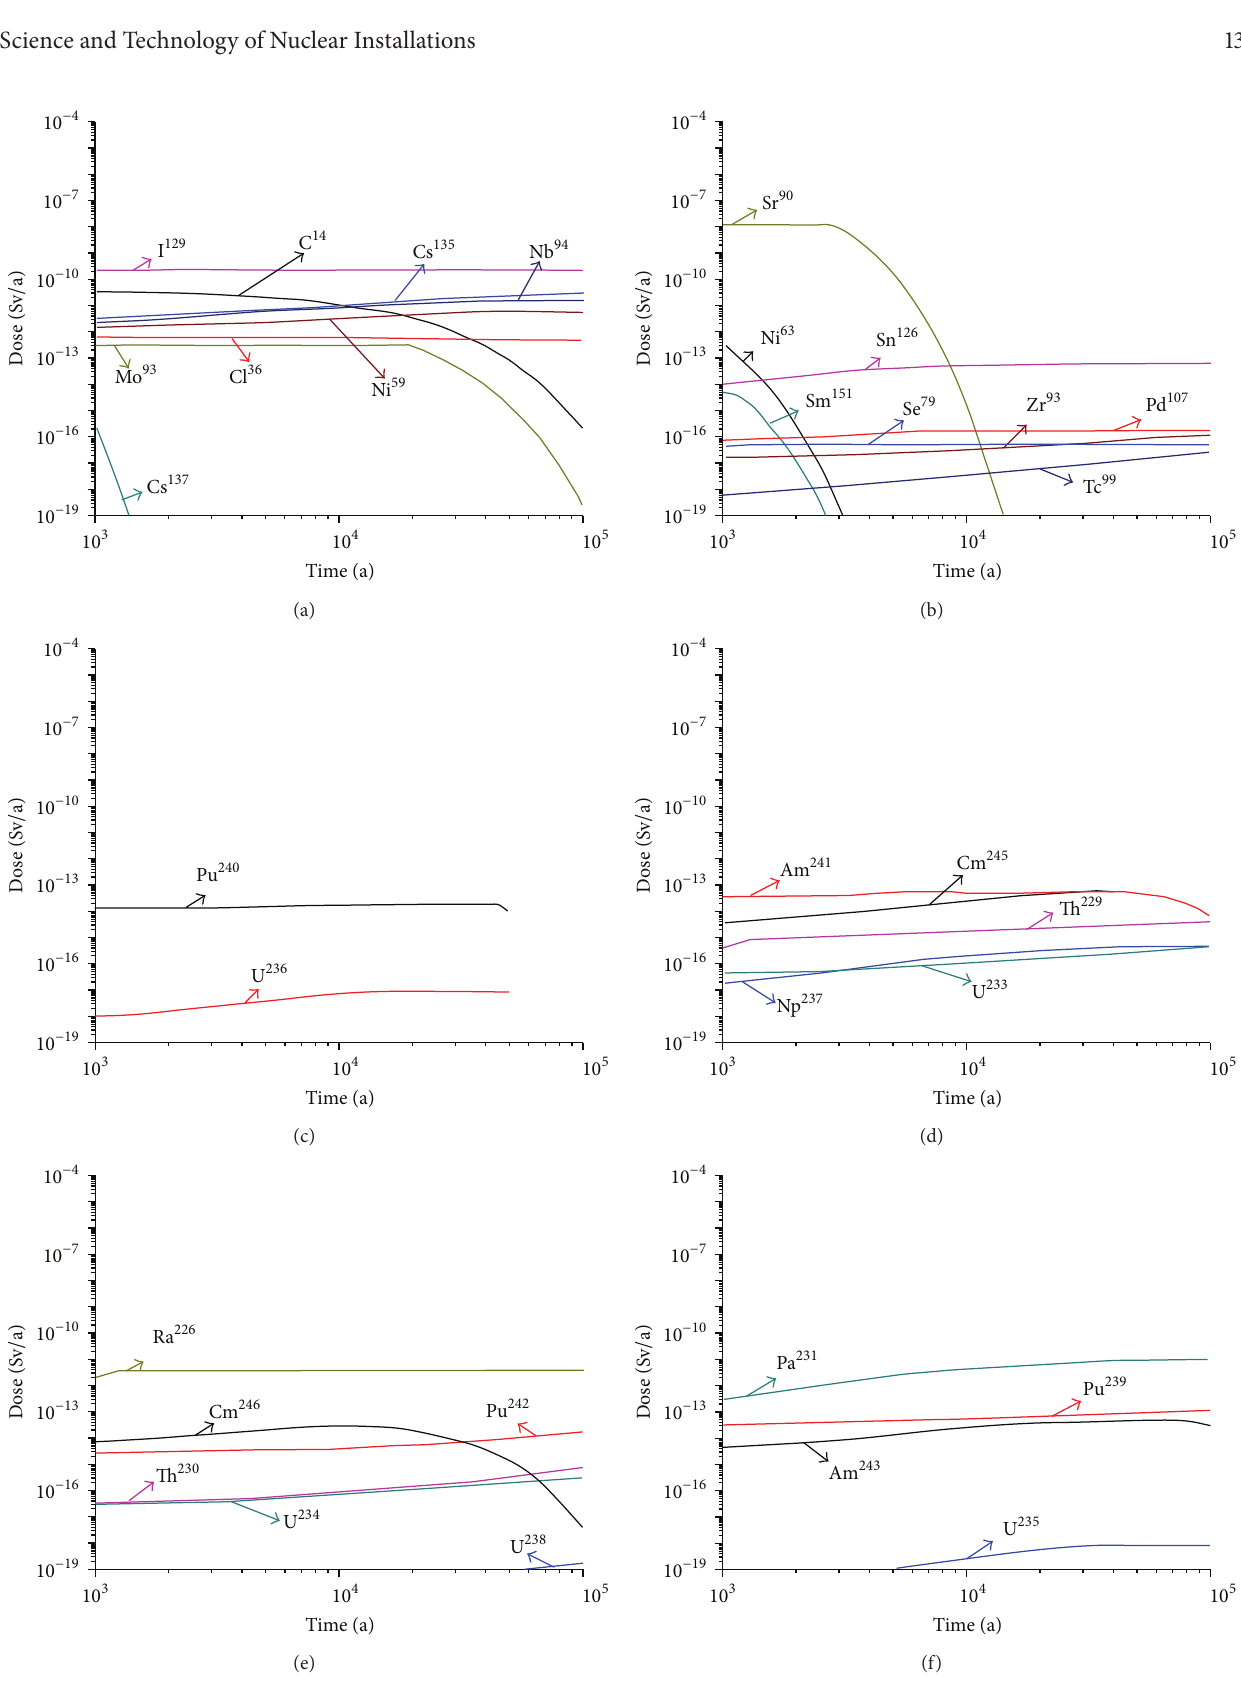
Figure 11: Estimated values of the committed effective dose to an adult in Sv/a, obtained from ingestion of well water containing relevant radionuclides of spent fuel that were released by the